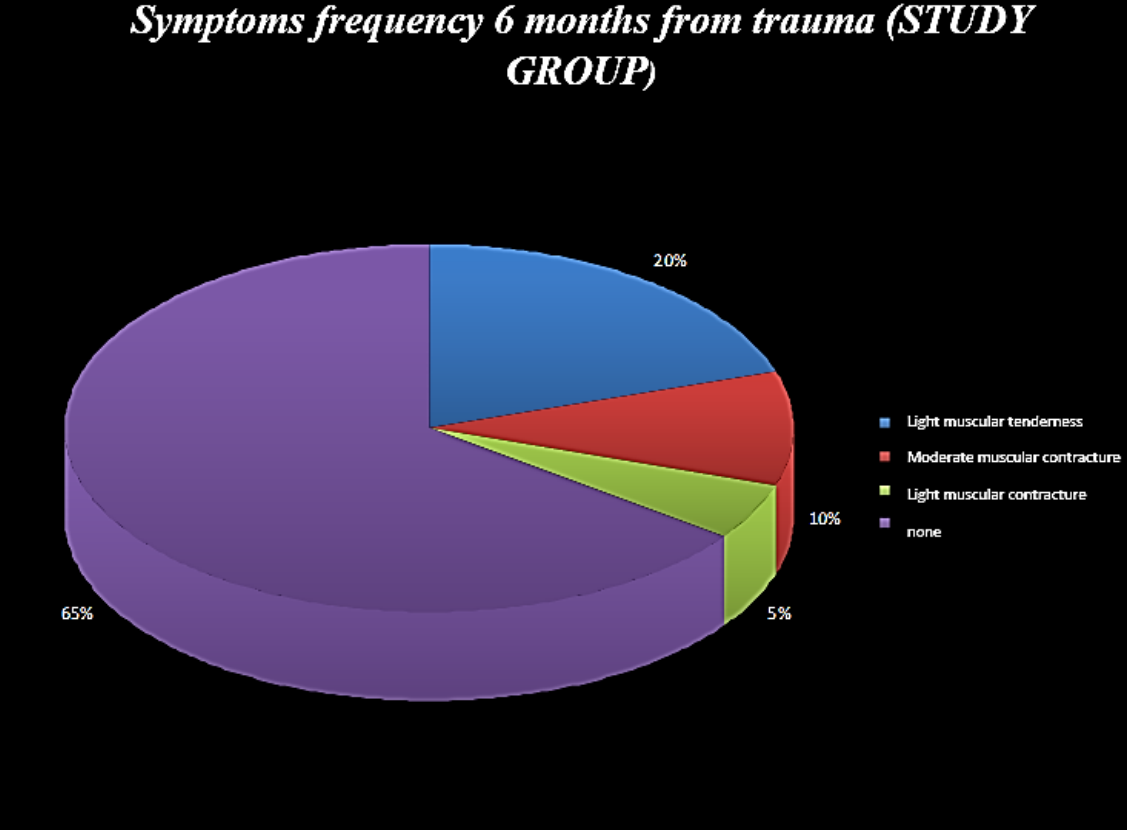
Figure 6. Symptom frequency 6 months from trauma (study group).